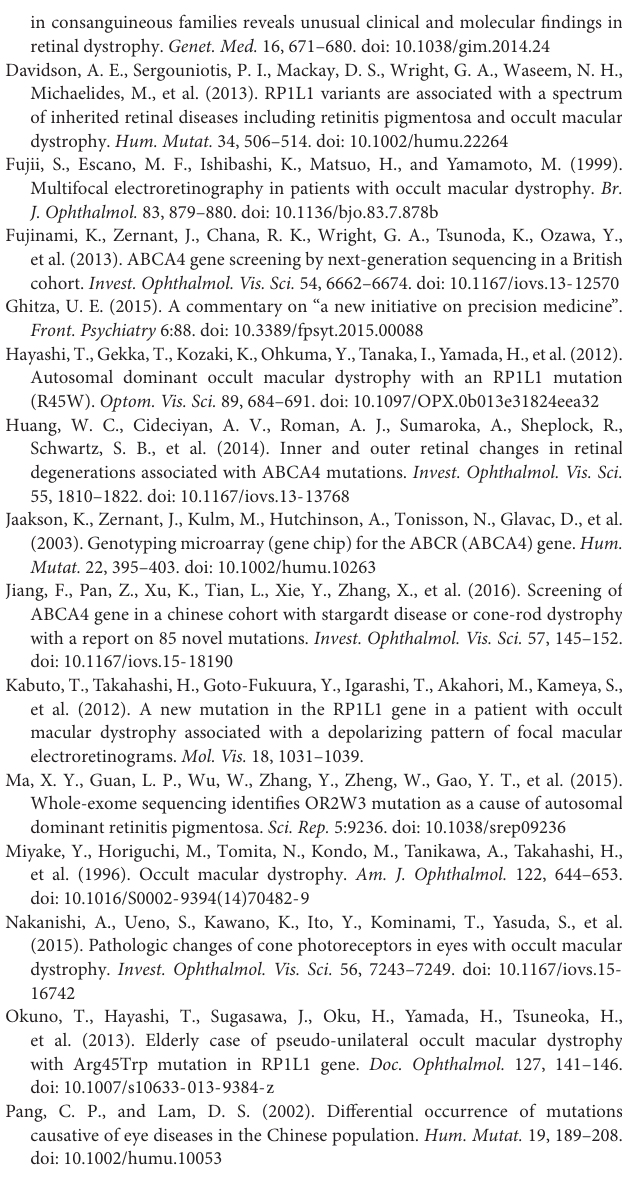
TABLE S1 | The 169 mutations identified by NGS technology in the present study. TABLE S2 | The 130 eye disease-related genes included in the capture